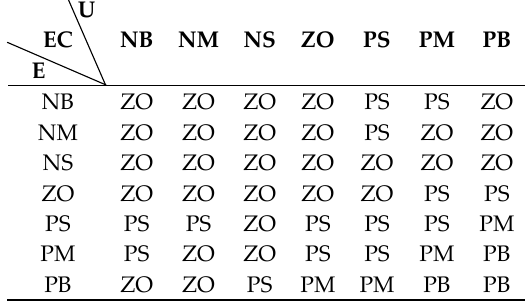
Figure 10 . Comparison of grain sieve loss variation before and after activating the controller.